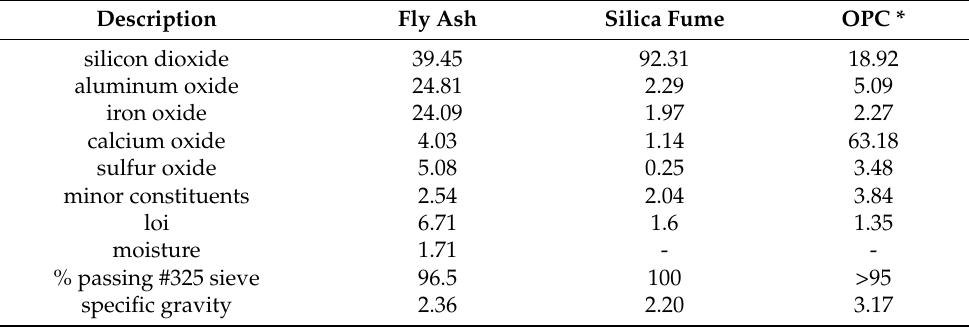
Table 1. XRF of fly ash and silica fume (oxide composition expressed in %age).